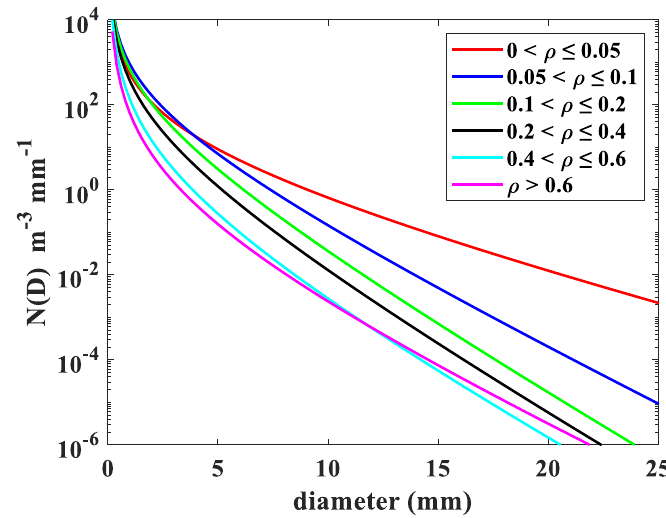
Figure 7. Mean snow PSDs for six density classes: 0 < 𝜌 ≤ 0.05 g cm −3 , 0.05 < 𝜌 ≤ 0.1 g cm −3 , 0.1 < 𝜌 ≤ 0.2 g cm −3 , 0.2 < 𝜌 ≤ 0.4 g cm −3 , 0.4 < 𝜌 ≤ 0.6 g cm −3 , and 𝜌 > 0.6 g cm −3 .